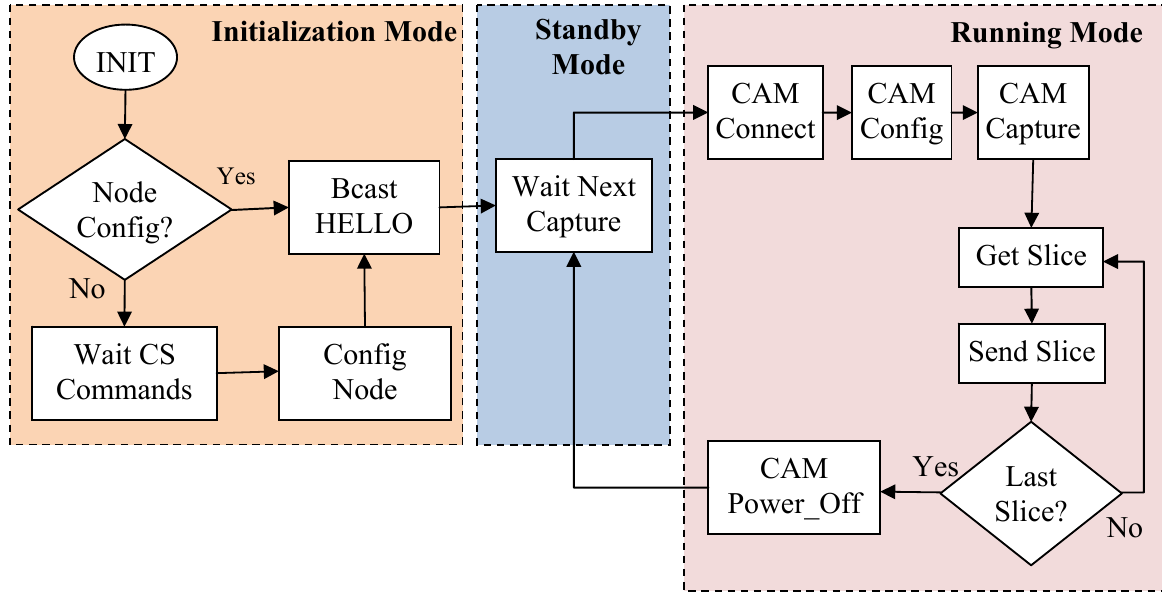
Figure 4. Flow diagram of the image sensor operating software, with its three differentiated working modes: Initialization, standby and